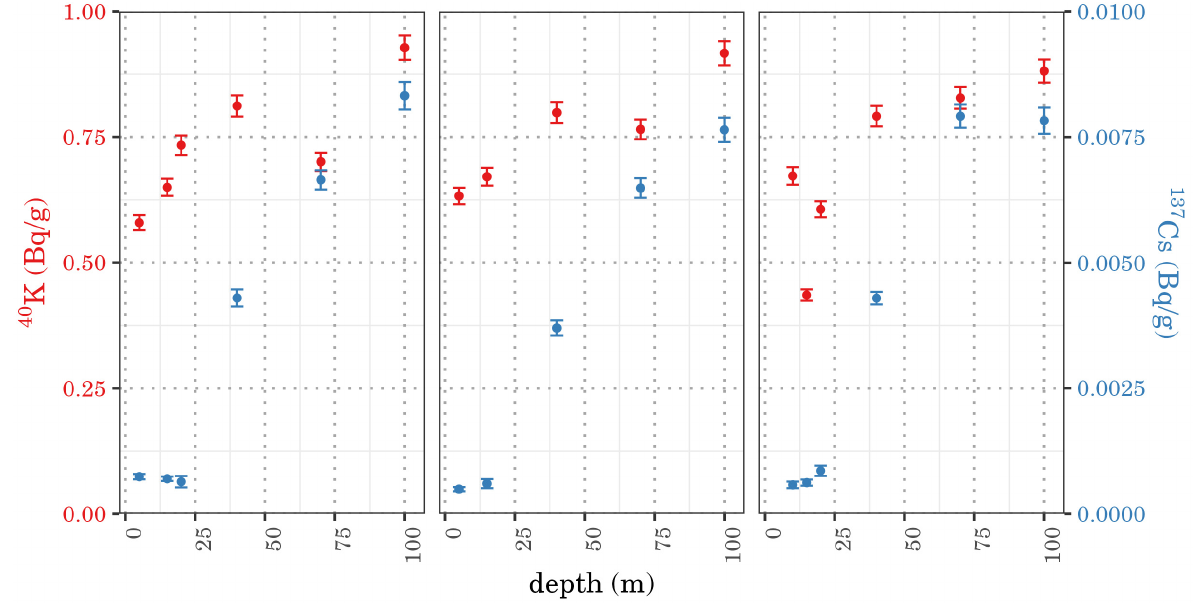
Figure 14. 40 K (left axis, red) and 137 Cs (right axis, blue) specific activity in marine sediments collected along the three transects T0 (left graph), T1 (center), and T5 (right).